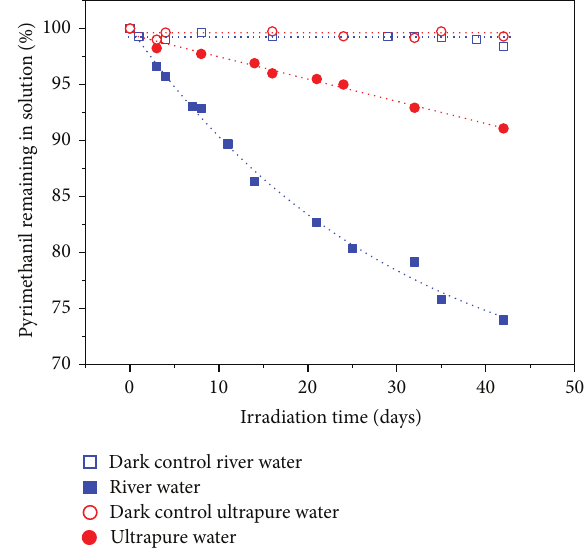
Figure 5: Photodegradation of pyrimethanil/HP- 𝛽 -CD inclusion complex in (open red circle, solid red circle) ultrapure and (open blue square, solid blue square) river water under simulated solar